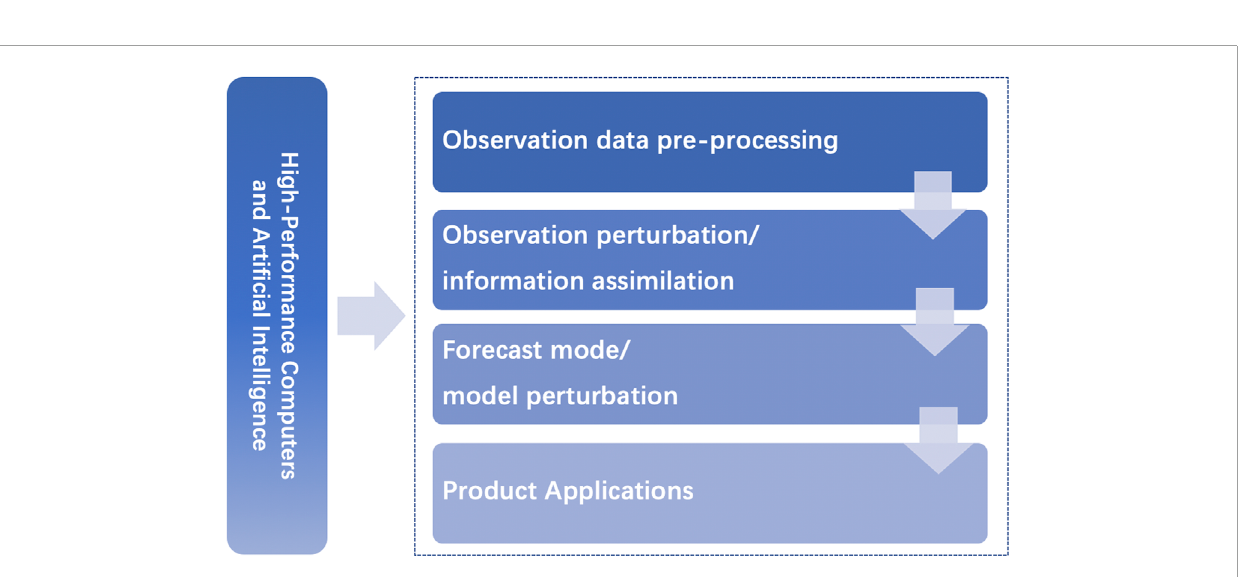
FIGURE 10 Schematic diagram of the atmospheric and oceanic numerical model prediction